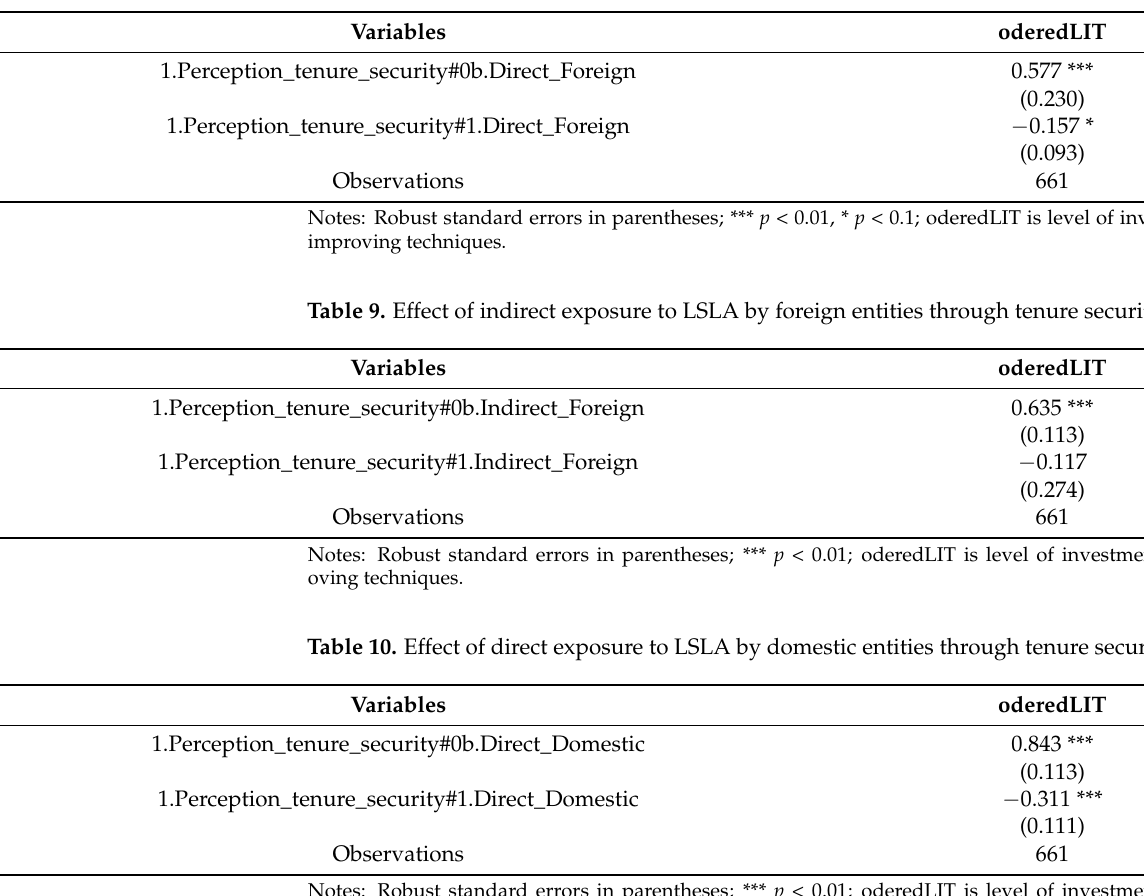
Table 8. Effect of direct exposure to LSLA by foreign entities through tenure security.